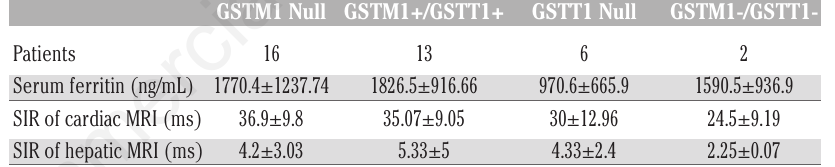
Table 2. Comparison of magnetic resonance data collection and ferritin values with dif- ferent genotypes.